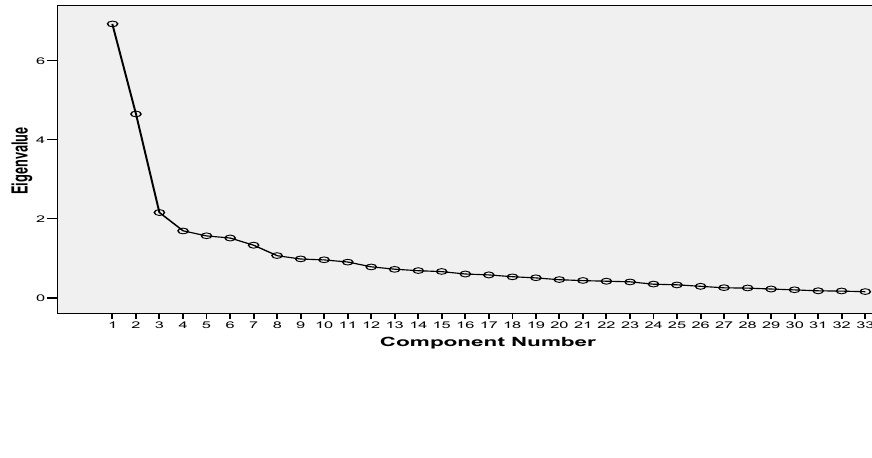
Graph 1: Scree Plot